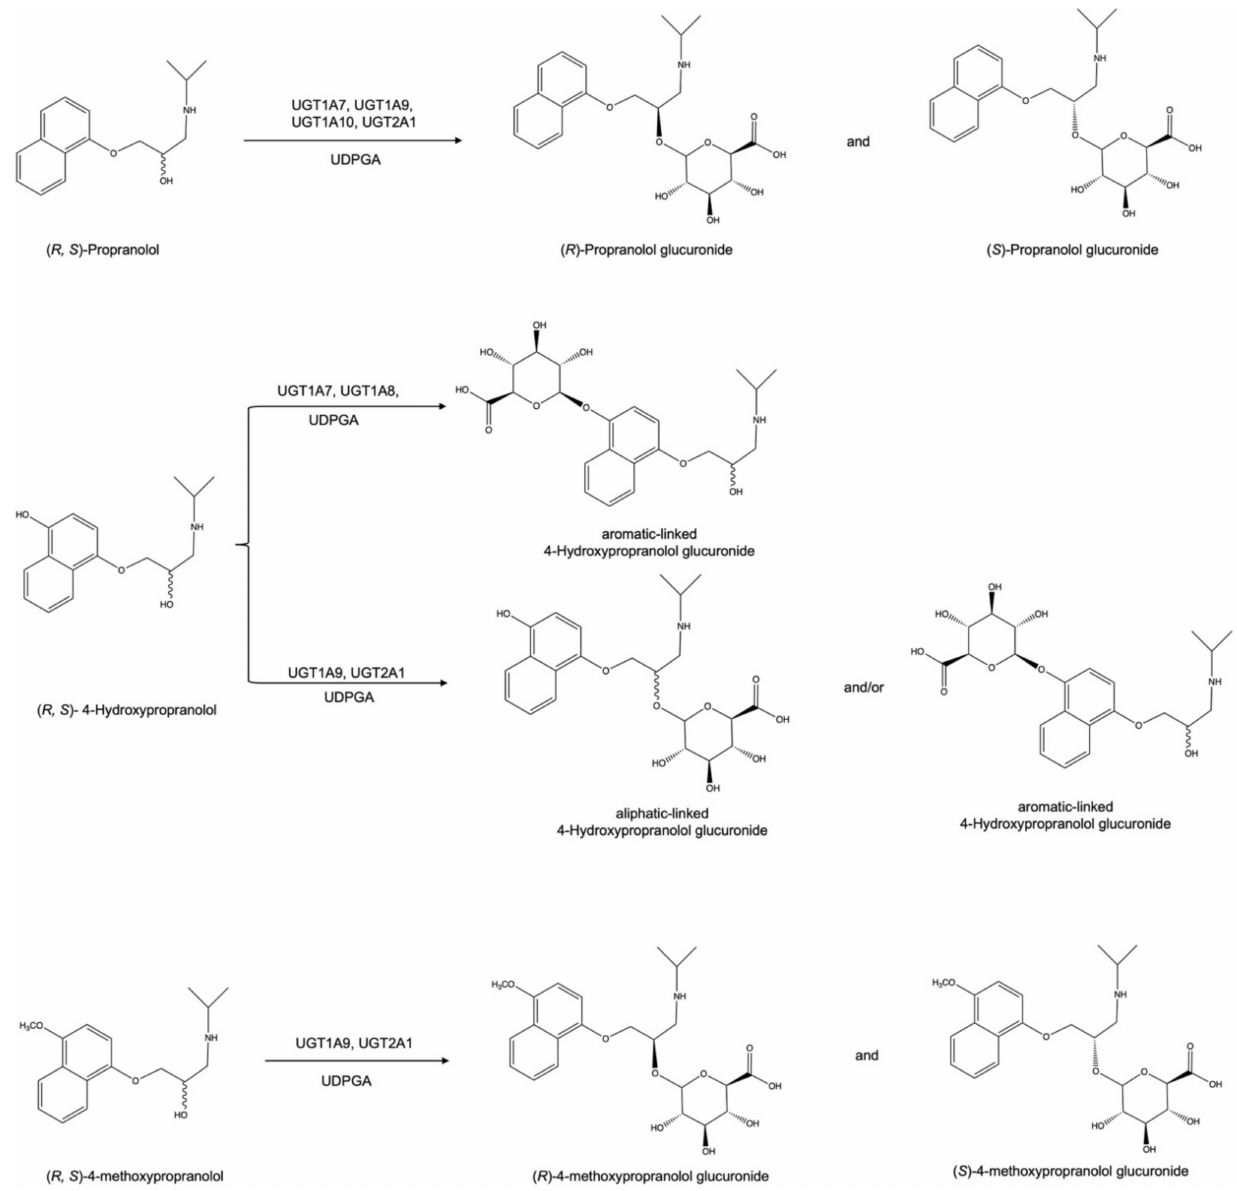
Figure 9. Reaction schemes for the glucuronidation of ( R , S )-propranolol, ( R , S )-4-hydroxypropranolol and ( R , S